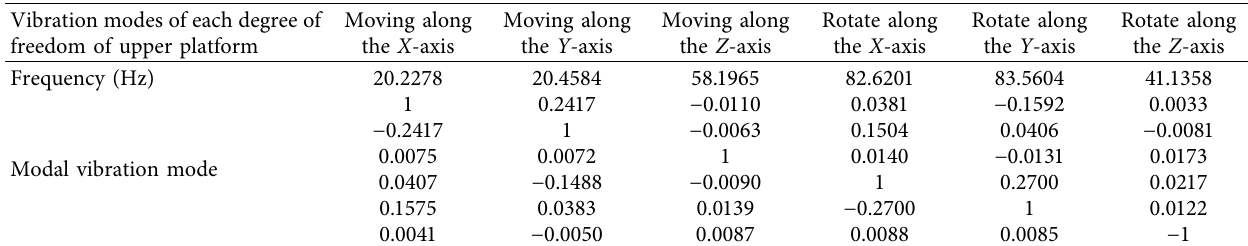
Modal vibration mode